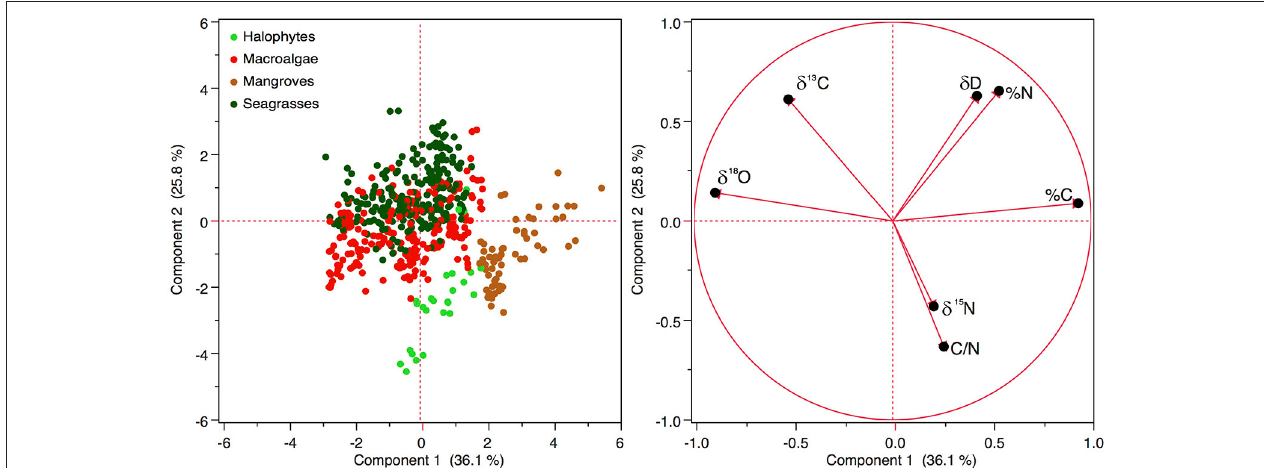
FIGURE 5 | Principal component analysis of the 5 types of primary producers according to the concentration of the stable isotopes ( δ 13 C, δ 15 N, δ 18 O, and δ D) and carbon and nitrogen and the ratio C/N in the plant tissues. Seston samples were excluded from the analysis as it was missing δ 18 O and δ D, so the loadings of seston on the axis are biased.